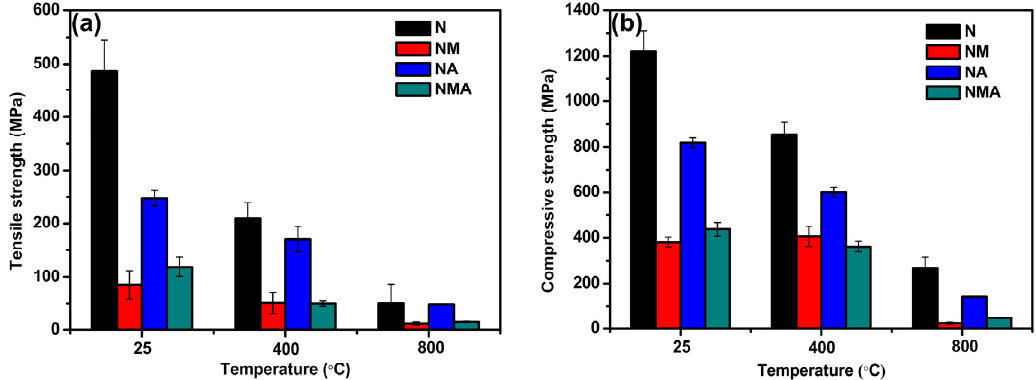
Figure 4. ( a ) Tensile strength and ( b ) compressive strength of Ni-based composites at different temperatures.